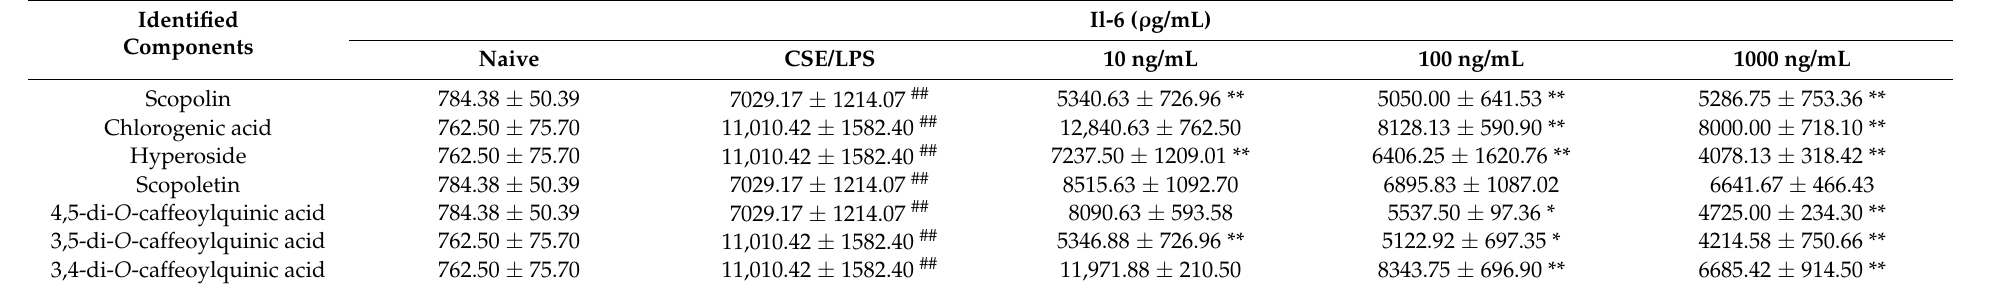
Table 2. The inhibitory effects of scopolin, chrologenic acid, hyperoside, scopoletin, 3-4-di- O -caffeoylquinic acid, 3-5-di- O -caffeoylquinic acid, 4-5-di- O -caffeoylquinic acid on IL-6 production by CSE/LPS-stimulated MH-S